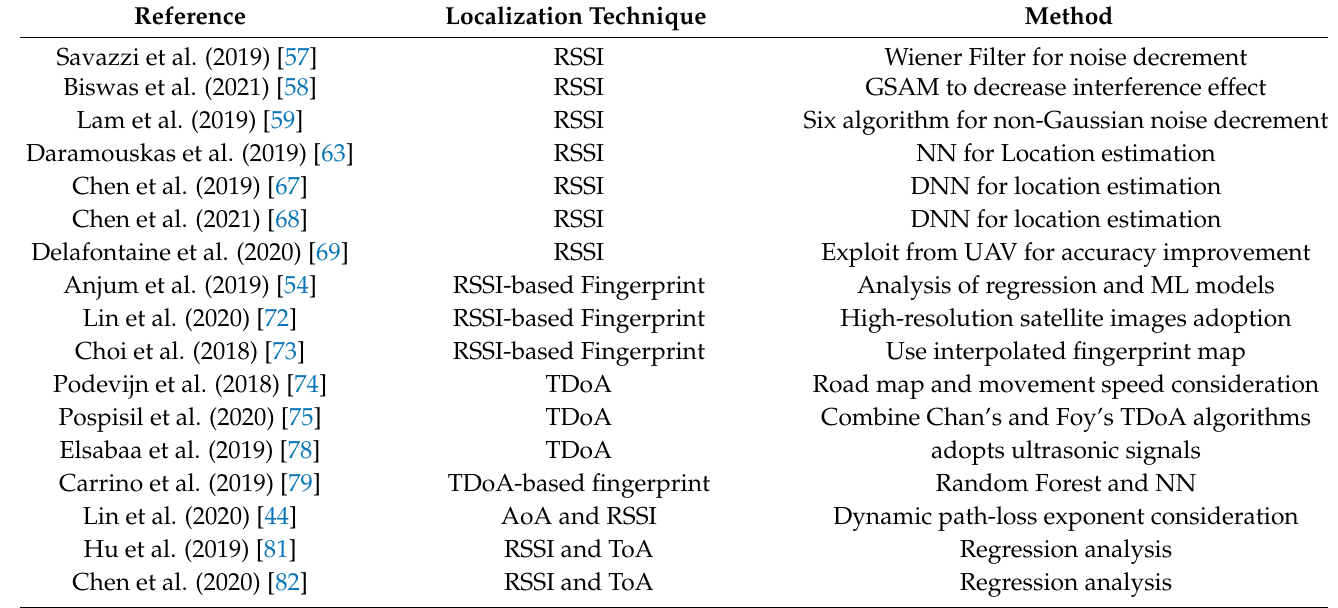
Table 2. Summary of proposed accuracy improvement methods for localization regardless of system